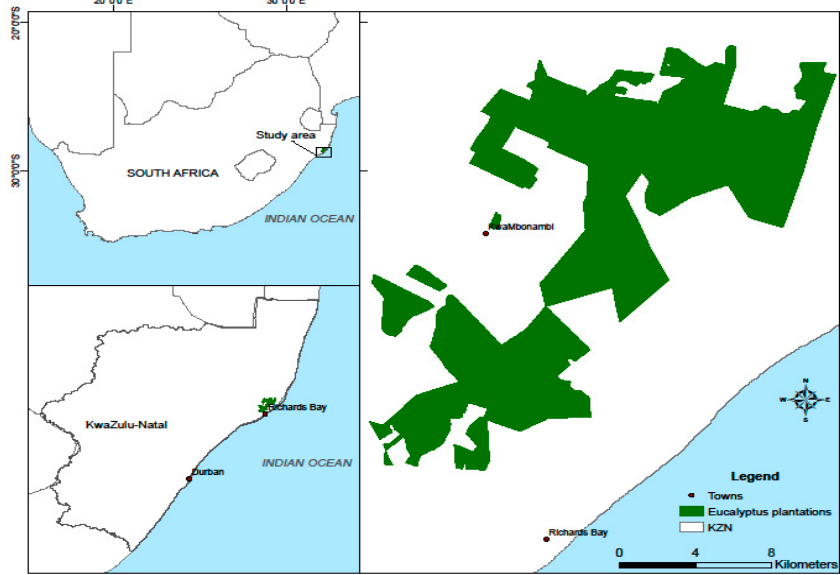
Figure 1. Location of the study area in KwaMbonambi, South Africa.